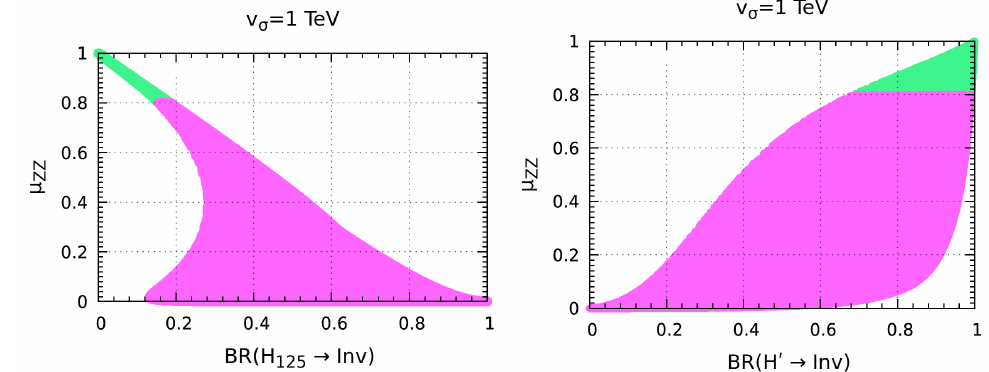
Figure 8 . Left panel : µ V V versus BR ( H 125 → Inv ) . Right panel : µ V V versus BR ( H 0 → Inv ) . Same color code as used in figure 7.